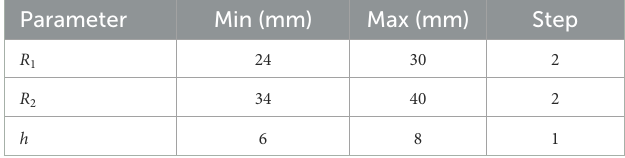
TABLE 4 Parameter ranges and steps of initial iteration.